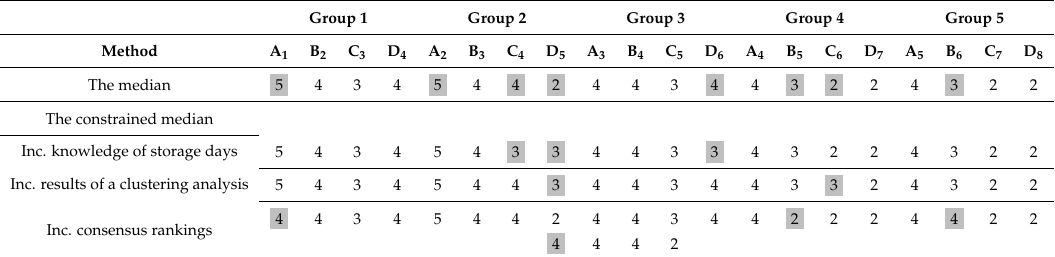
Table 9. The median and the constrained medians for each sample in every group after incorporating knowledge of storage days, results of a clustering analysis, and consensus